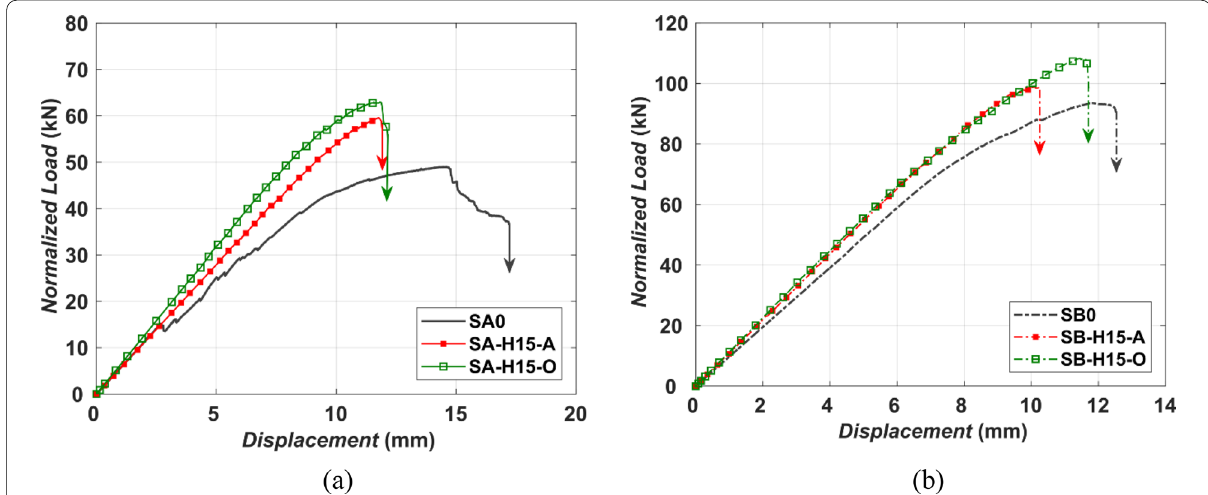
Fig. 11 Load–deflection curves of specimens with different location of the HFRP sheet relative to the column face in Group a SA; b SB.